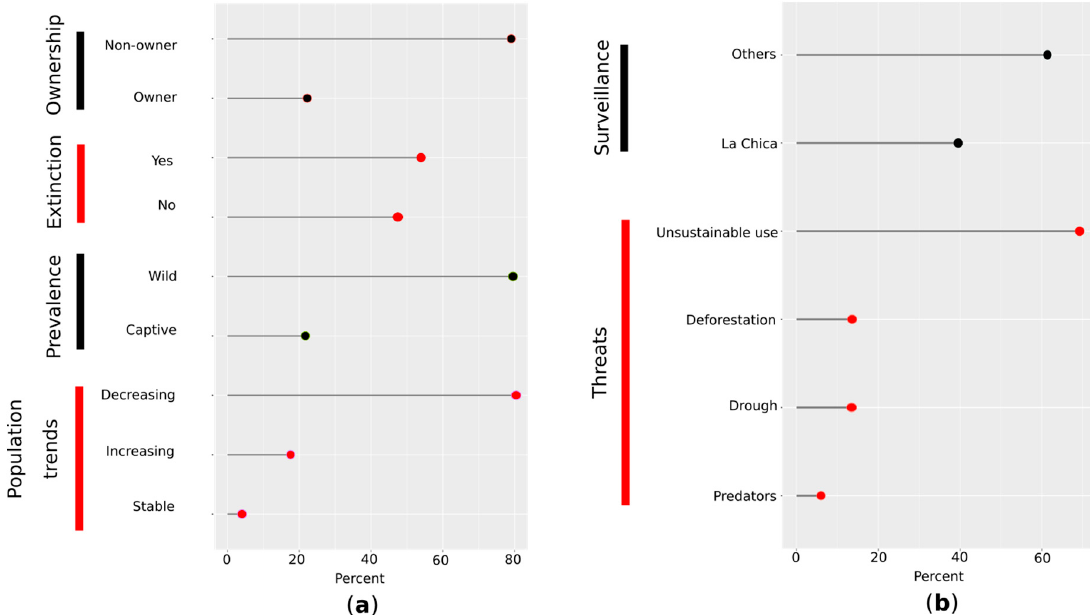
Figure 2. Perceived conservation outcomes from Macanao inhabitants regarding ( a ) population status of the yellow ‐ shouldered Amazon and ( b ) main threats and the impact of nest surveillance.